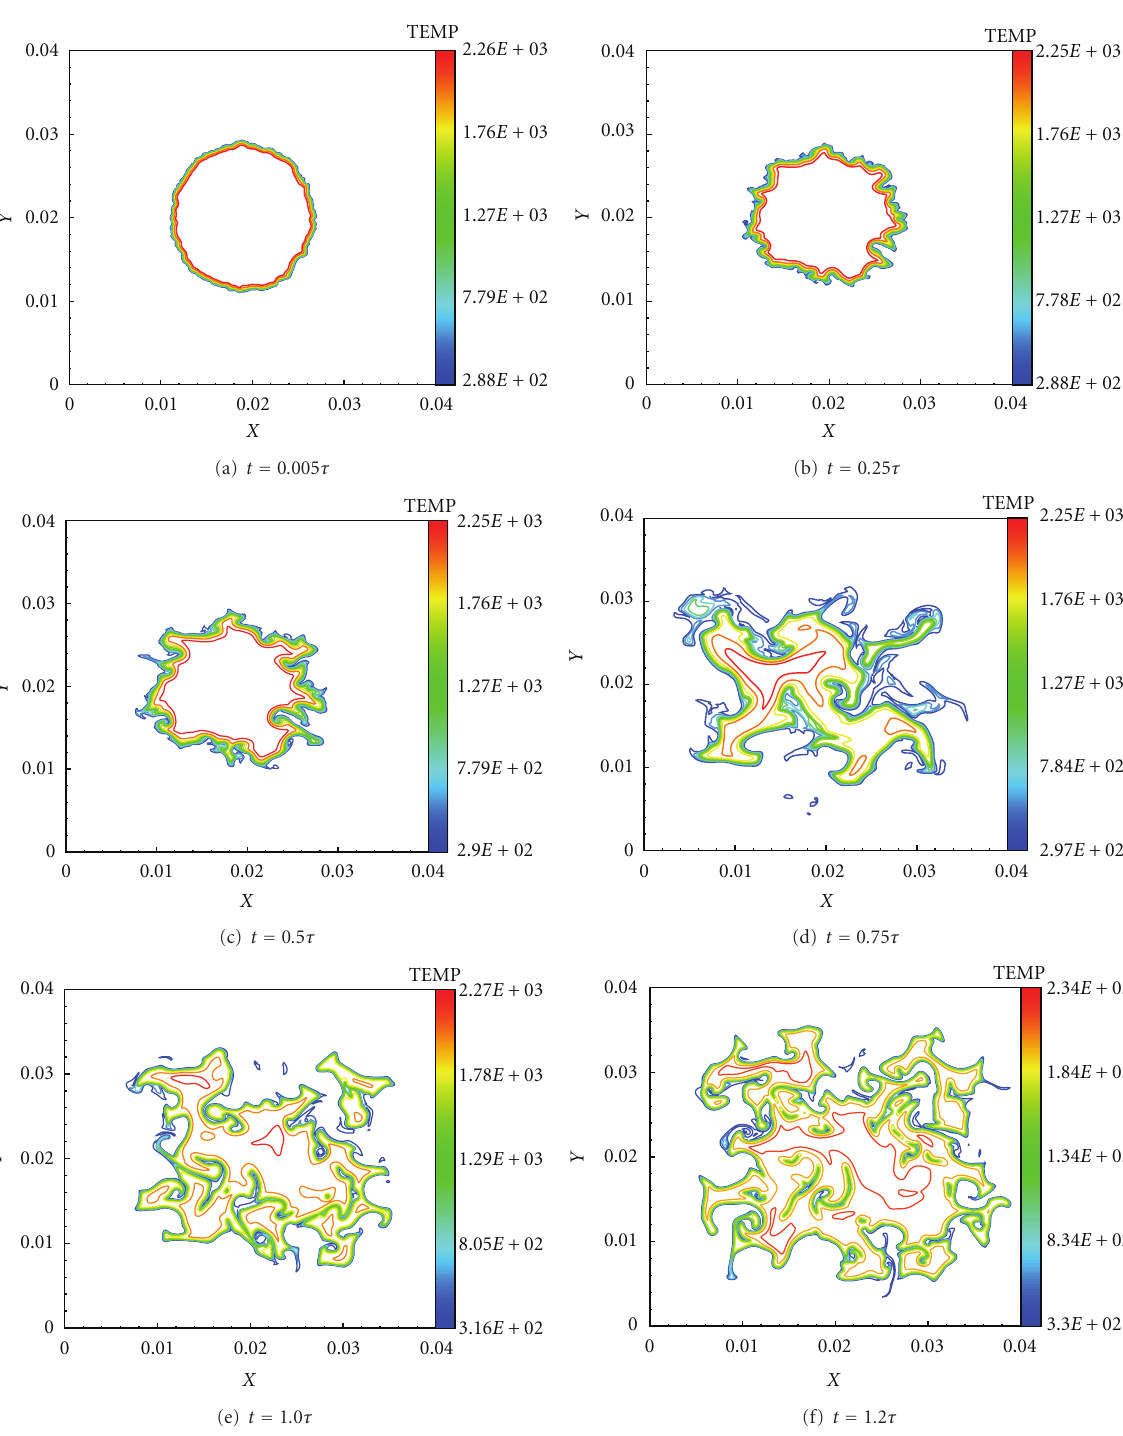
Figure 6: Time evolution of the iso-contours of temperature (along the z = 2 . 0cm plane) for case 4 (without volume